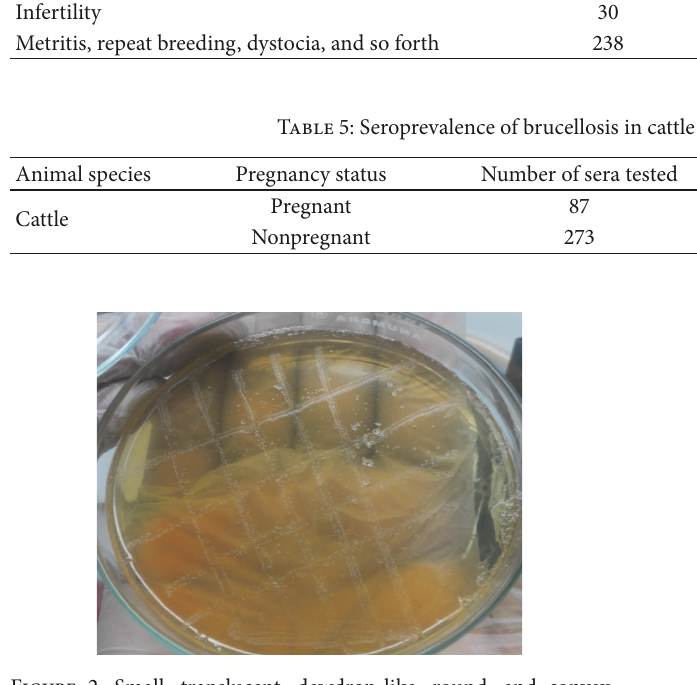
Figure 2: Small, translucent, dewdrop-like, round, and convex growth with smooth margins on Brucella selective agar media.